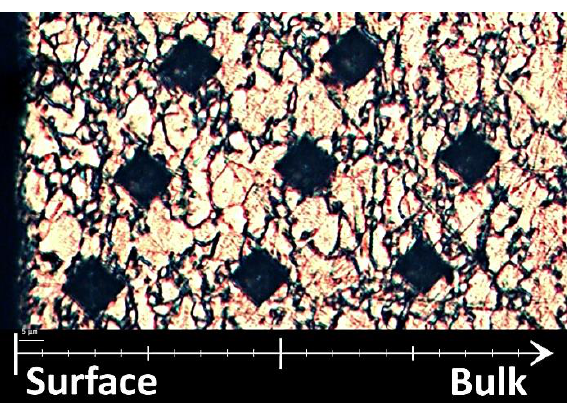
Figure 6. Example of microhardness indentations. The machined surface is on the left side and the indentations are perpendicular to this surface.